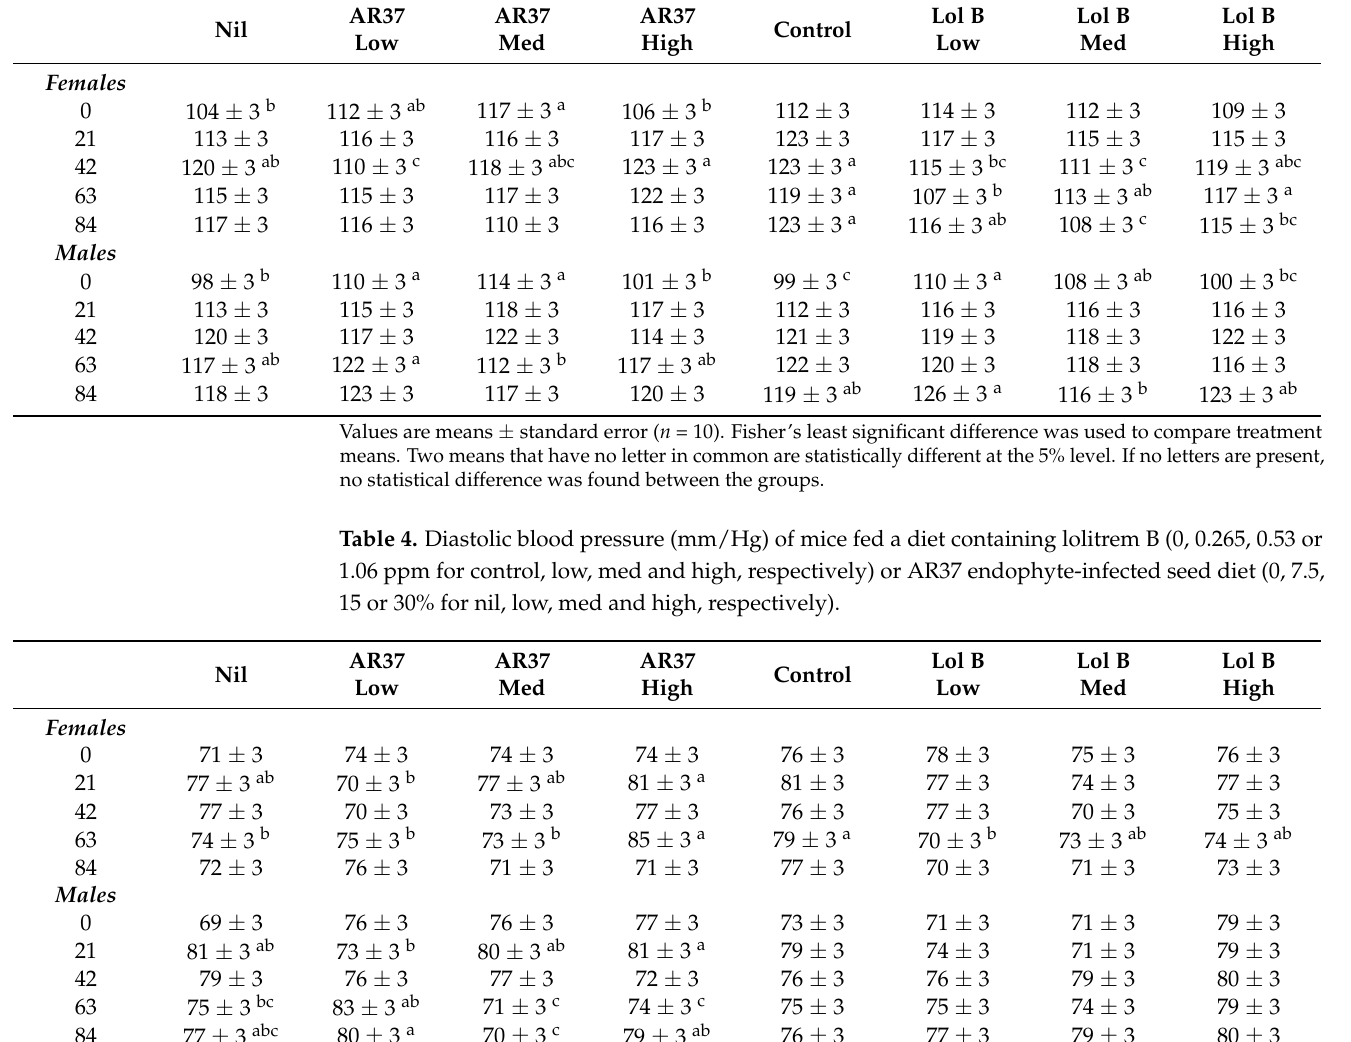
Table 3. Systolic blood pressure (mm/Hg) of mice fed a diet containing lolitrem B (0, 0.265, 0.53 or 1.06 ppm for control, low, med and high, respectively) or AR37 endophyte-infected seed diet (0, 7.5, 15 or 30% for nil, low, med and high, respectively). AR37 AR37 AR37 Nil Low Med High High